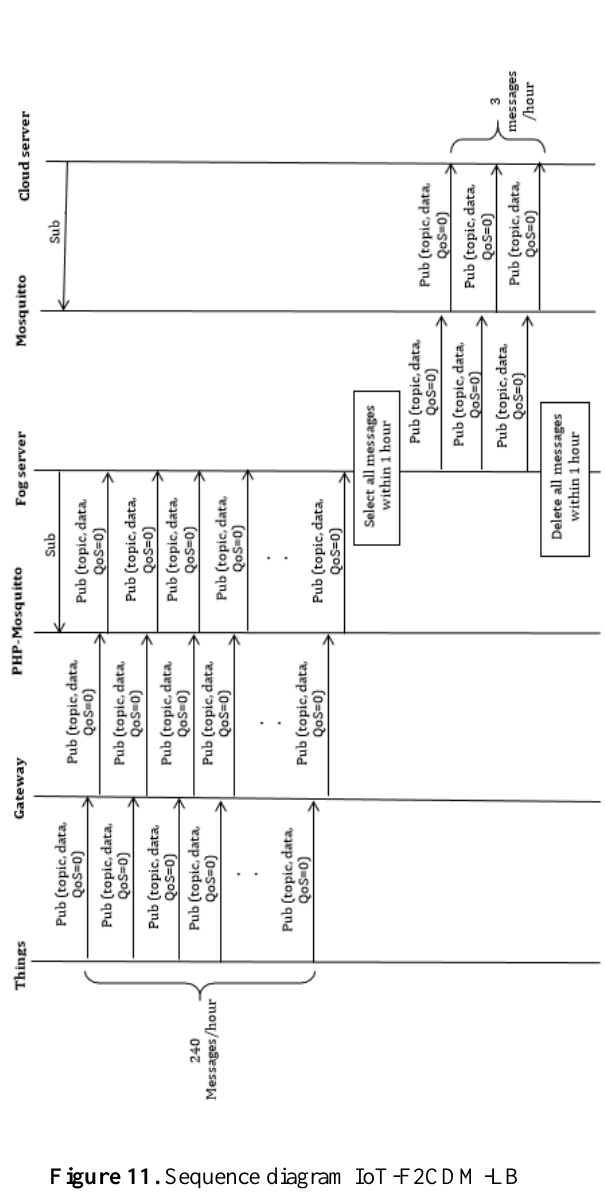
Figure 11. Sequence diagram IoT-F2CDM-LB